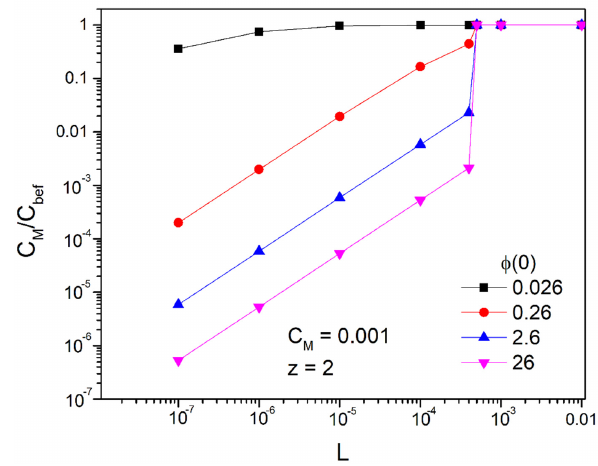
Figure 7. C M as a function of L (m) for z = 2, concentration C M = 0.001 mol Figure 7. 𝐶 (cid:3014) 𝐶 (cid:3416) as a function of L (m) for z = 2, concentration 𝐶 (cid:3014) = 0.001 (cid:2923)(cid:2925)(cid:2922) C bef (cid:3029)(cid:3032)(cid:3033) tials φ (0) (V). potentials ϕ ( 0 ) (V).